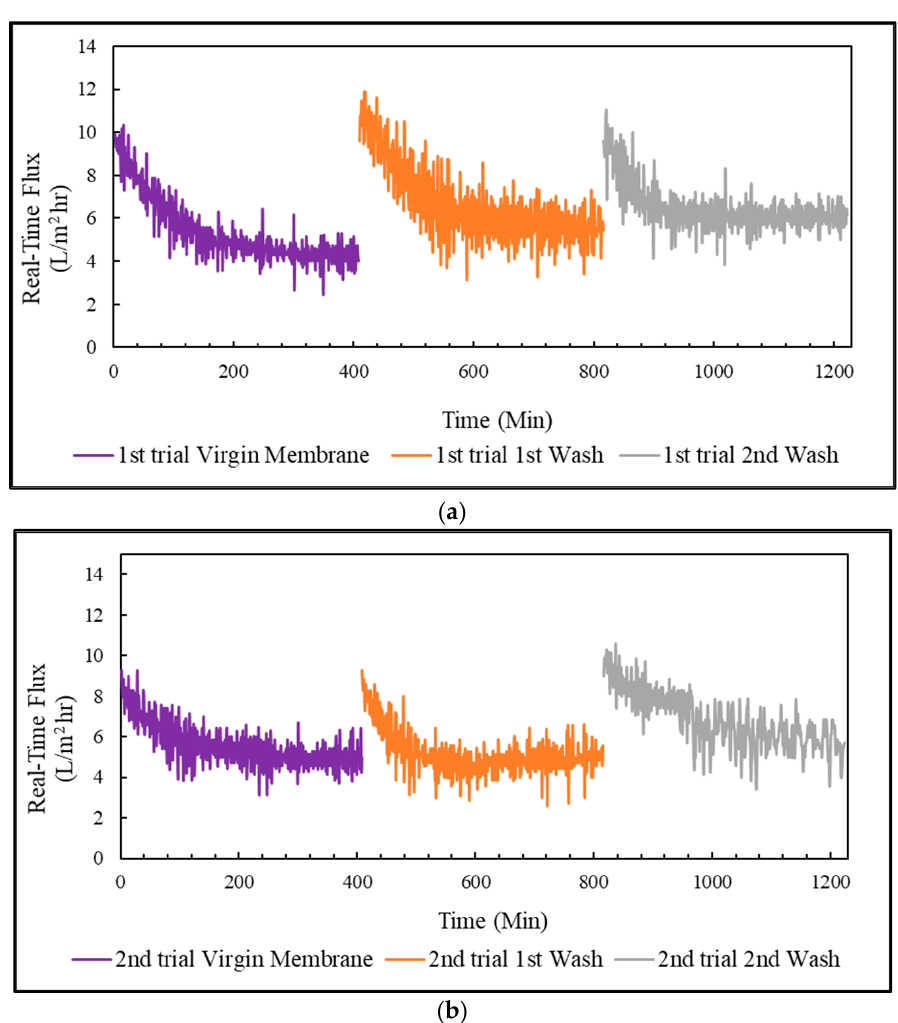
Figure 8. PSWW treatment in PRO mode: ( a ) 1st trial of PRO mode; ( b ) 2nd trial of PRO mode.